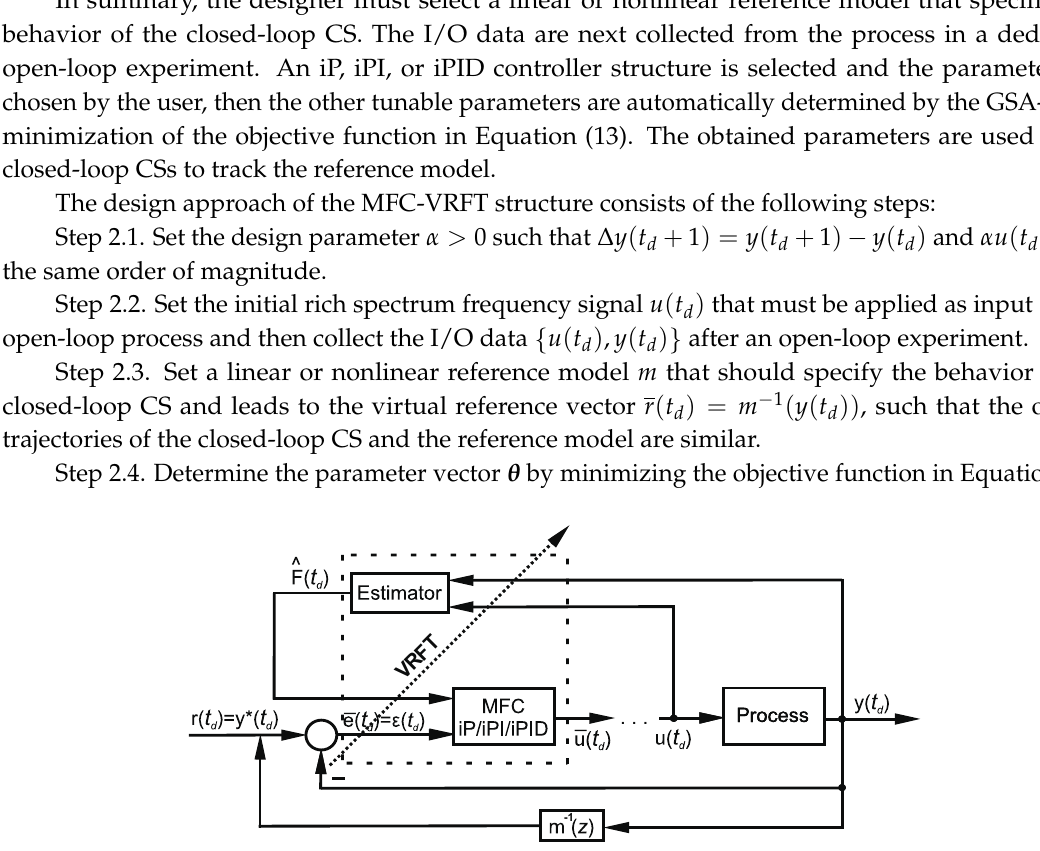
Figure 3. The CS structure with mixed MFC-VRFT algorithms.